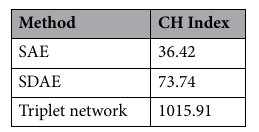
Table 3. CH index of each algorithm.